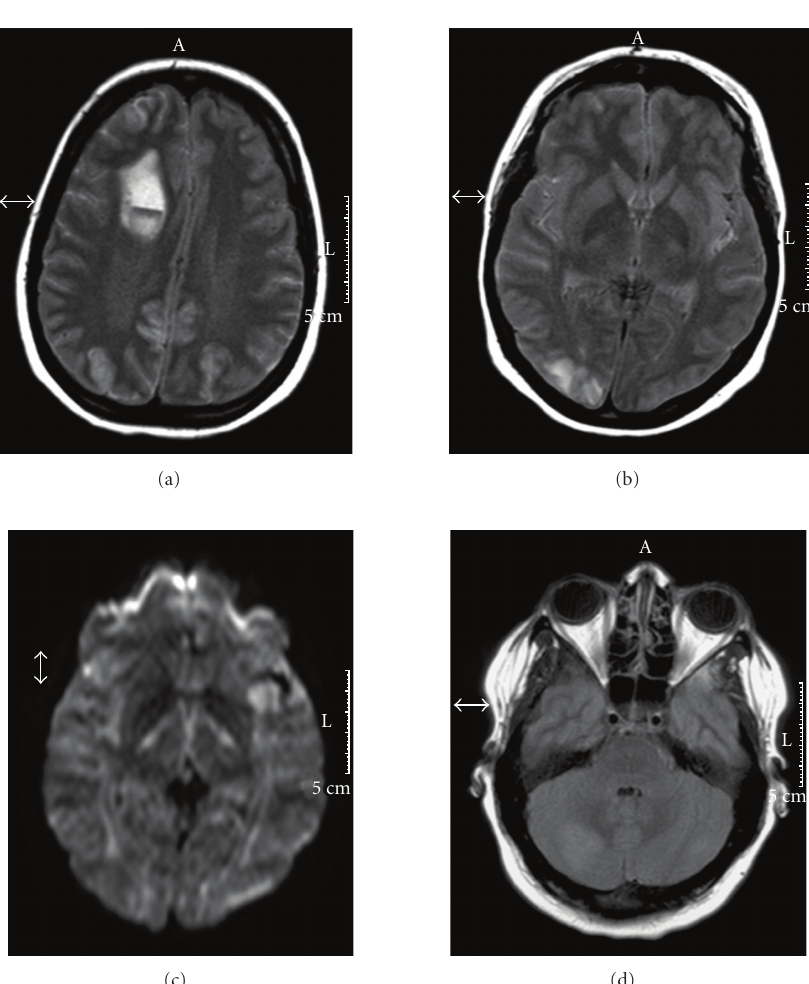
Figure 2: Axial FLAIR sequences show an ICH in the right frontal lobe (a). The combination of hyperintensities rostral of the ICH and in the right occipital lobe (b) with a normal DWI (c) in these areas is consistent with a vasogenic edema. The alterations in the cerebellum were largely unchanged (d).